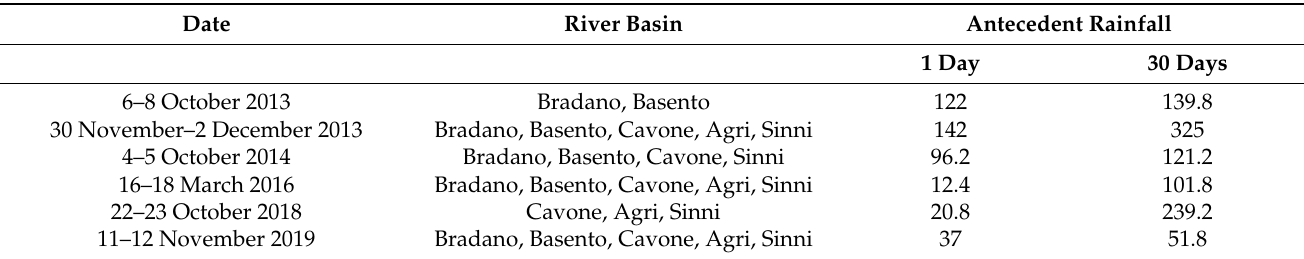
Table 2. Flood records in the Metaponto region along with their antecedent rainfalls that caused them. Adopted from